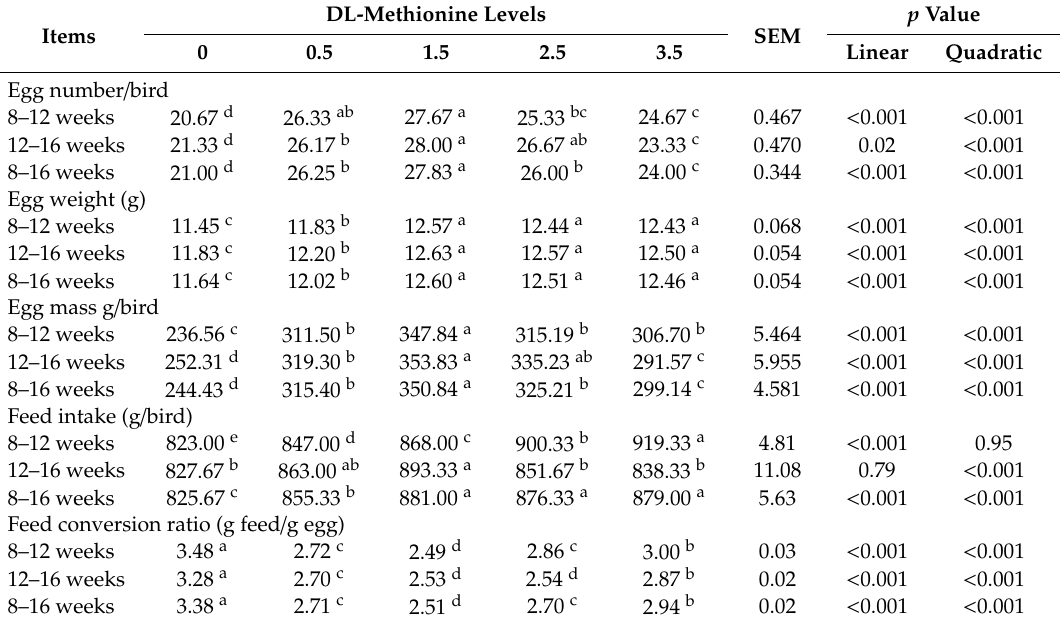
Table 2. Productive performance of Japanese quail as a ff ected by dietary